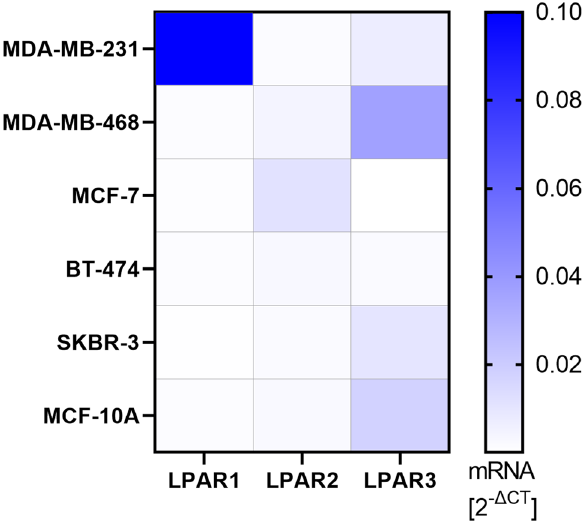
Figure 5. LPAR1–3 expression on mRNA level of different breast (cancer) cell lines. The heatmap shows relative LPAR mRNA expression compared to four different housekeeping genes (Coiled-Coil Serine Rich Protein 2 (CCSER2), Symplekin Scaffold Protein (SYMPK), Ankyrin Repeat Domain 17 (ANKRD17), and Pumilio RNA Binding Family Member 1 (PUM1)) using the 2 −ΔCT -method. Values > 0.10 are presented in dark blue (relative LPAR1 mRNA expression of MDA-MB-231 is 0.60). n = 3 replicate experiments.